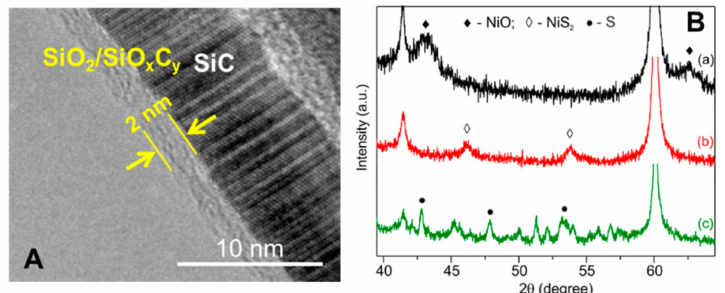
Figure 2. ( A ) TEM micrograph showing the presence of a thin SiO 2 /SiO x C y passivated layer on the surface of SiC; ( B ) Comparison of PXRD analyses of different samples: (a) NiO/SiC foam catalyst, (b) freshly prepared NiS 2 /SiC foam catalyst after sulfidation reaction with a mixture of H 2 S (4